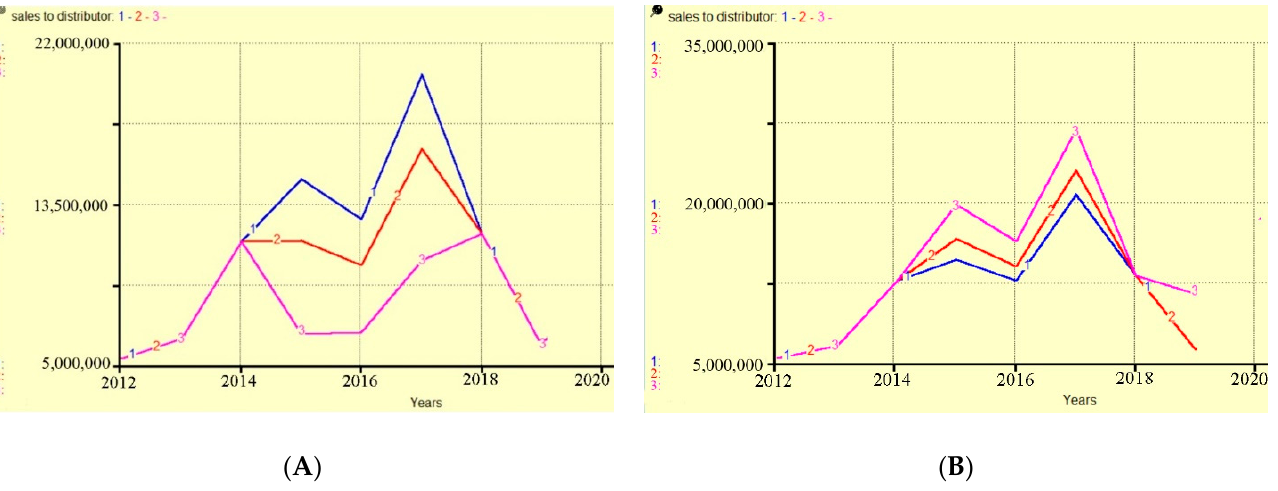
Figure 6. Numerical sales in different scenarios of API and warehouse planning between 2012–2019: ( A ) API availability related scenarios, ( B ) API supply and planning related to production rate and warehouse stock related scenarios .